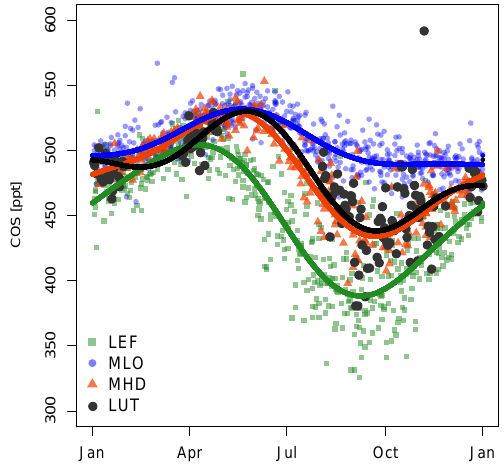
Figure 13. COS seasonal cycle of four sites: Wisconsin, USA (LEF); Mauna Loa, USA (MLO); Mace Head, Ireland (MHD); and Lutjewad, the Netherlands (LUT); the data of the latter site are pre- sented in this study. COS mole fractions for the LEF, MLO and MHD sites were measured from flask samples at a GC-MS by NOAA/ESRL (Montzka et al., 2007). The NOAA/ESRL data are shown as flask pair means from individual sampling events. All NOAA measurements are plotted as function of time of the year and cover a period between 2000 and 2015 for LEF, MLO and MHD. In situ COS measurements with the QCLS at the Lutjewad site during 2014–2015 are shown as daily averages (black). A two-harmonic seasonal cycle is fit through the